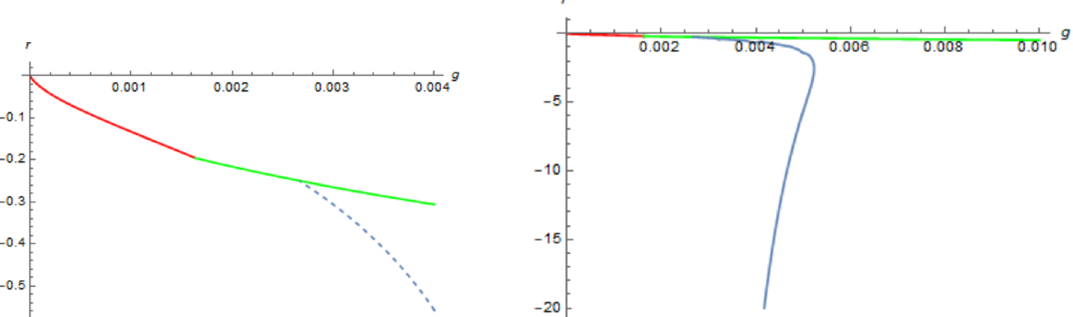
Figure 5 . The phase diagram in case of α 0 = − 1 / 48 . The blue line corresponds to the asymmetric one-cut to the symmetric two-cut transition, the red line to the asymmetric one-cut to the symmetric one-cut transition and the green line to the phase transition between the symmetric phases. The asymmetric one-cut to the symmetric two-cut phase transition on the left image is plotted in the dashed style as this transition is less accurate near the origin of the parameter phase due to the order of the Padé approximation. The triple point was obtained at g c = 0 . 0016 .